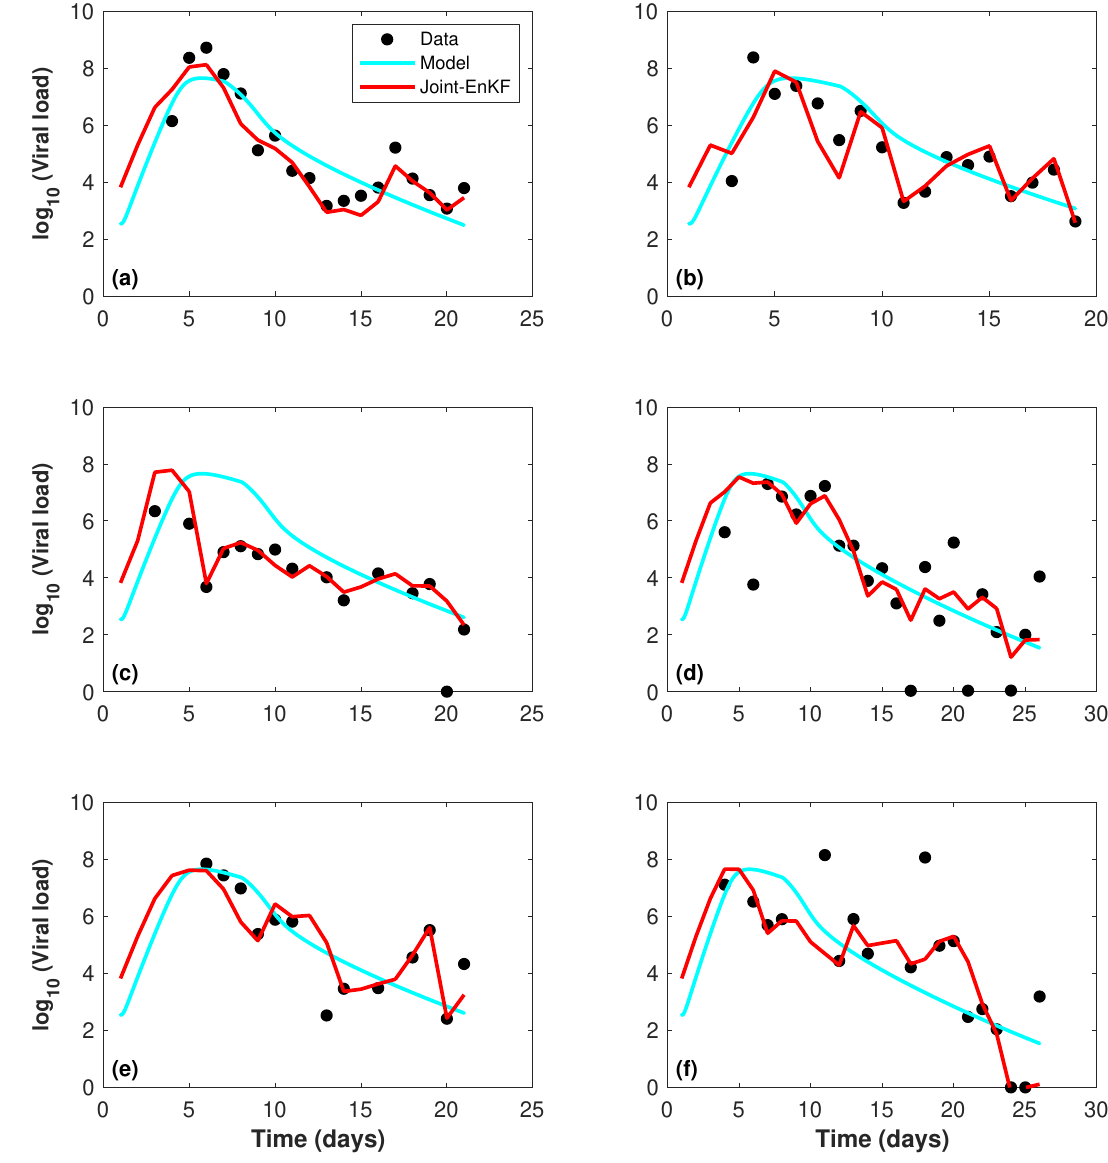
Figure 3. Time series of the viral load for ( a ) Patient 1; ( b ) Patient 2; ( c ) Patient 3; ( d ) Patient 4; ( e ) Patient 5; and ( f ) Patient 6—relative to the model free-run (without assimilation), joint-EnKF, and the real data